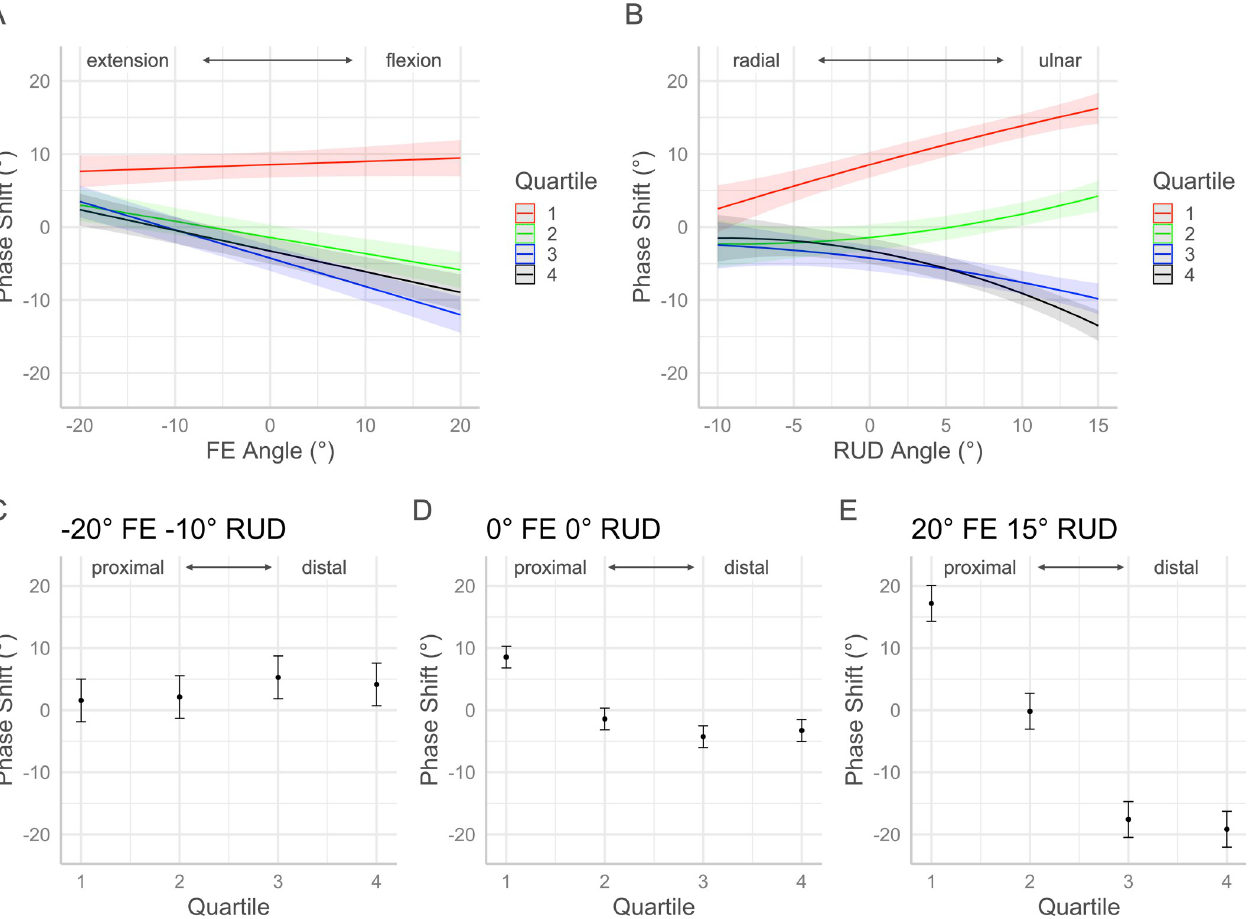
Fig 10. Effects of FE and RUD wrist postures on the mean shape signature phase shift within each quartile. Panel A shows the effects of varying FE angle with 0˚ RUD. Panel B shows the effect of varying RUD angle with 0˚ FE. Panels C/D/E show the predicted values with 95% confidence intervals for each quartile for an extended radially deviated posture (panel C), a neutral posture (panel D), and a flexed and ulnarly deviated posture (panel